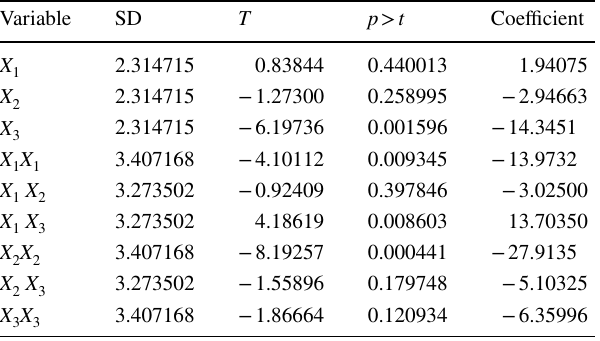
Table 4 ANOVA coefficient of regression and t checking